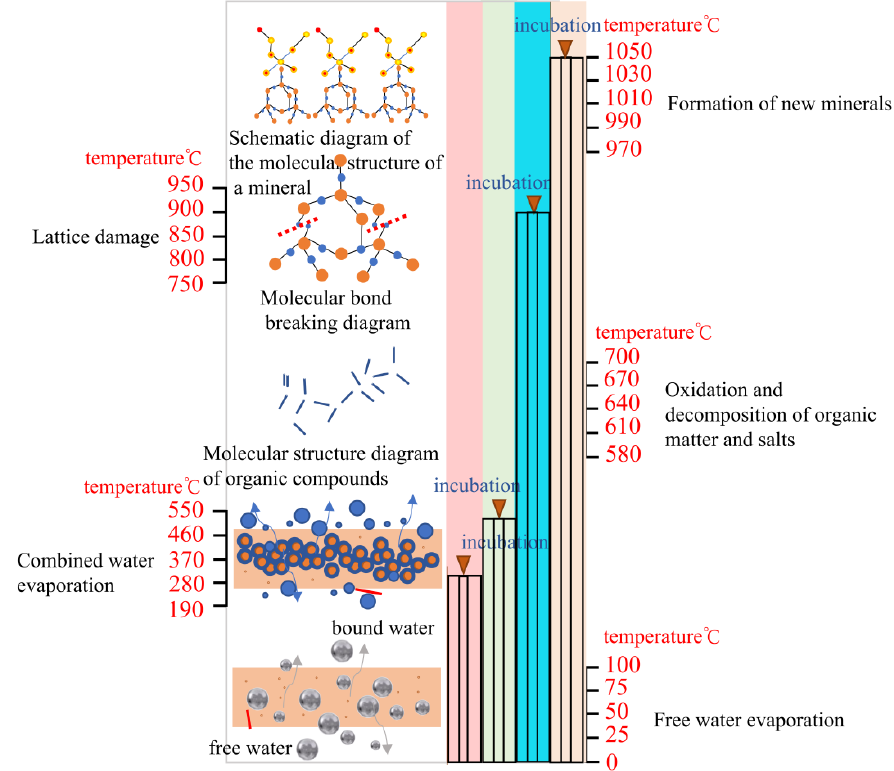
Figure 19. Internal reflection of recycled brick at different temperatures.